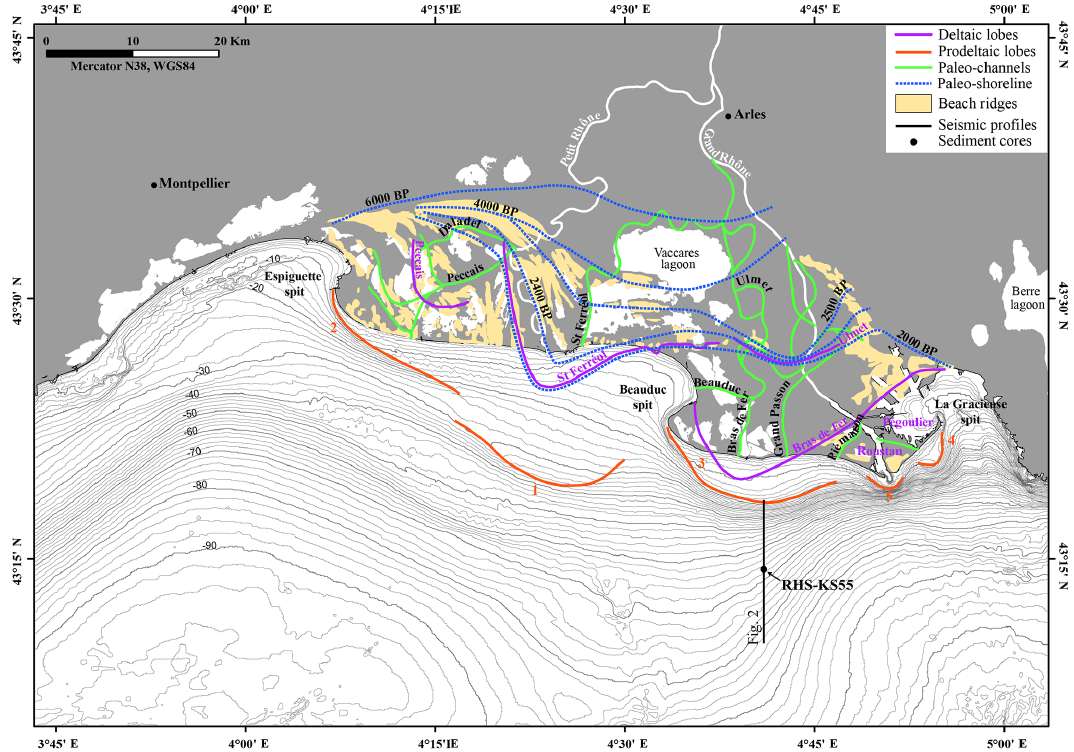
Figure 1. Offshore and onshore morphology of the Rhône deltaic system. This map is based on the compilation of Berné et al. (2007) and Vella et al. (2008). The successive shifting of the Rhône distributaries under natural and/or anthropic influence during the middle and late Holocene led to the formation of several deltaic lobes. Steps in the present-day morphology correspond to the position of the paleo-delta fronts that can be linked to known paleo-distributaries of the Rhône: (1) early Saint Ferréol, (2) Peccais, (3) Bras de Fer, (4) Pégoulier, and (5) modern Roustan distributary. The map of relict morpho-sedimentary units in the Rhône delta plain (paleo-shorelines, beach ridges and onshore deltaic lobes) is based on L’Homer et al. (1981), Arnaud-Fassetta (1998), Vella (1999), and Provansal et al. (2003). Thick line and black dot correspond respectively to chirp seismic profile (Fig. 2) and sediment core RHKS-55 presented in this study.